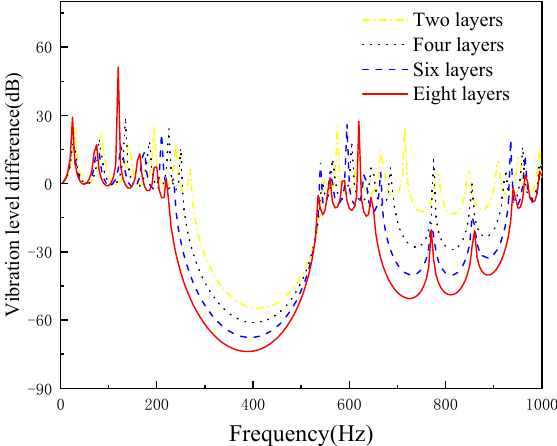
Figure 5. The effect of the local resonant layer number on the cushioning performance.